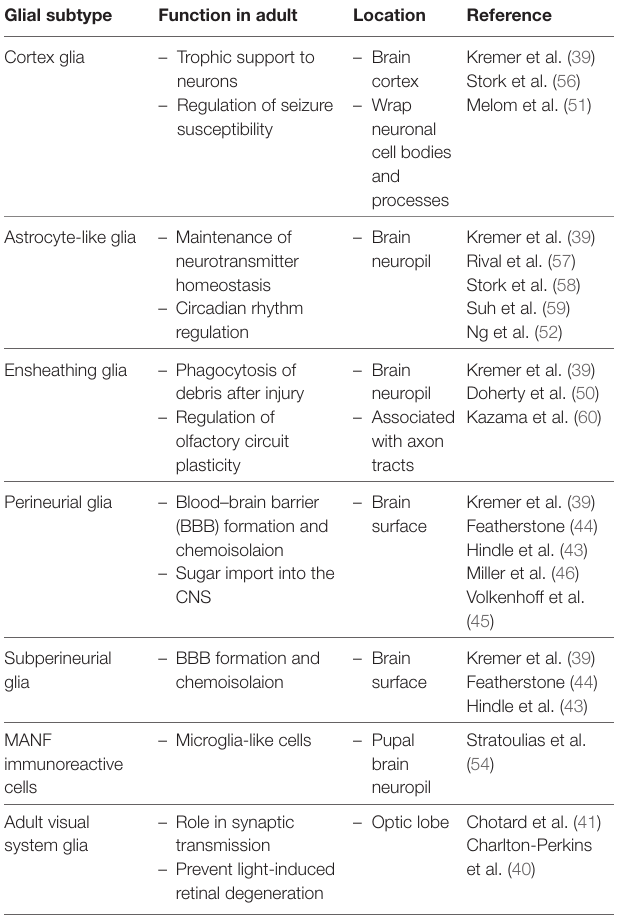
TABLe 1 | Glial subtypes and their location and functions in the